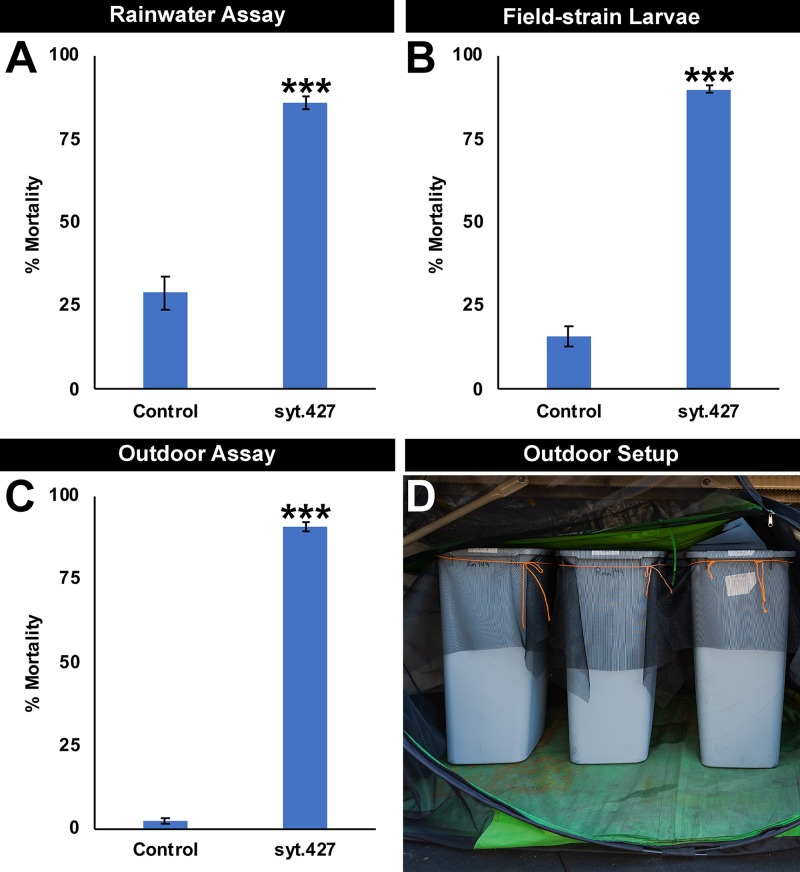
Simulated-field and semi-field evaluation of syt.427 activity.Activity of syt.427 was confirmed in assays conducted with rainwater (A; data shown are from replicate experiments that included a total of 120 larvae per treatment) and using larvae from a field strain of A. aegypti mosquitoes generated from eggs collected in Trinidad (B; data shown were combined from replicate experiments that included a total of 240 larvae per treatment). High levels of larval mortality were induced by syt.427 in semi-field trials (C) conducted in a contained outdoor roof top laboratory (D). The semi-field data shown (C) were compiled from multiple biological replicate experiments conducted on a total of 180 larvae/treatment. Data are represented as mean percentage larval mortality and were evaluated with t-tests; error bars denote SEM. ***P<0.001 when compared with control-fed larvae.